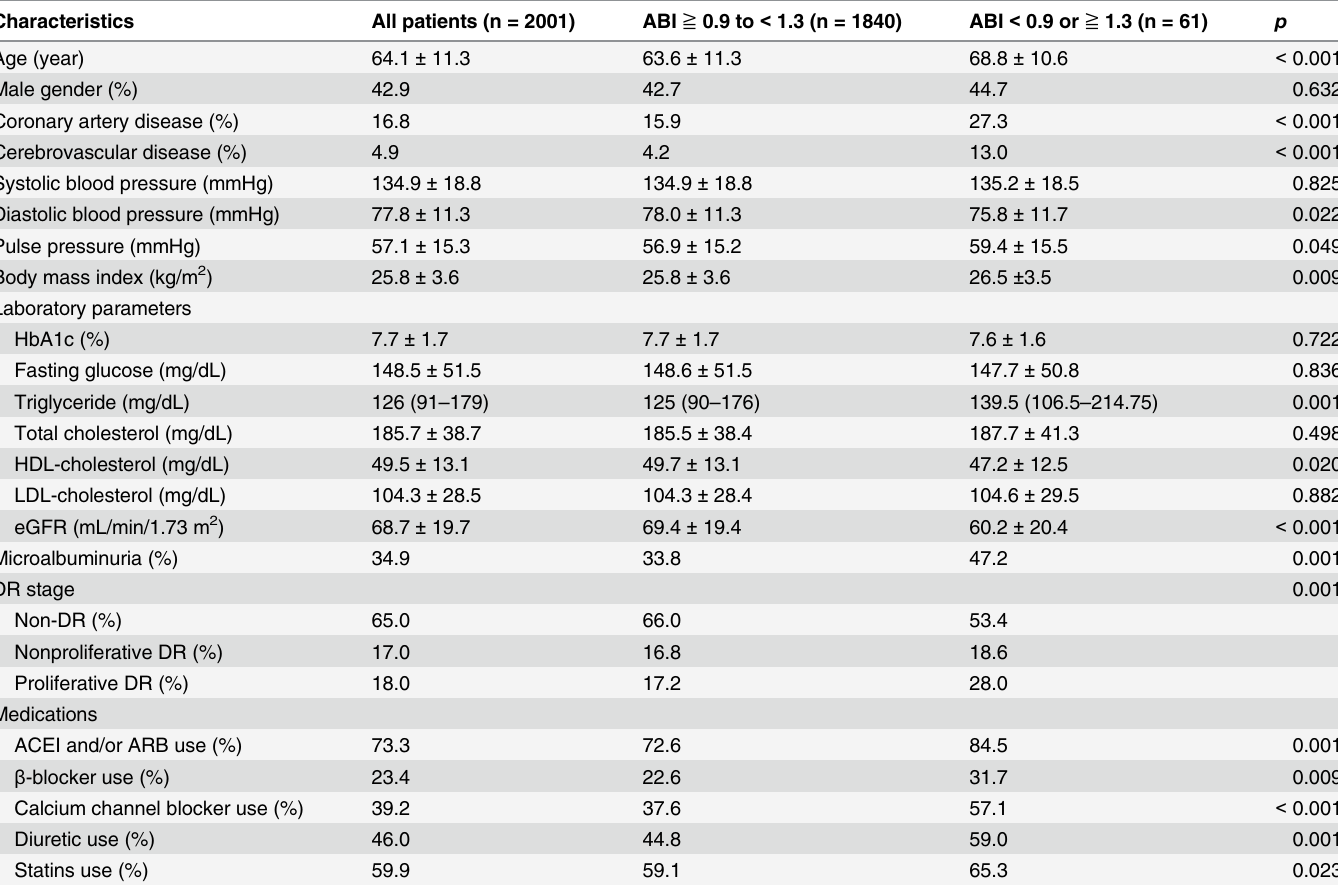
Table 1. Comparison of baseline characteristics between patients with and without a normal ABI of ≧ 0.9 to < 1.3.